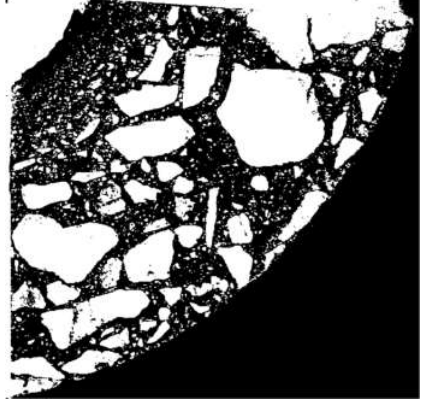
Figure 8. Image of sample after segmentation procedure Step 3.